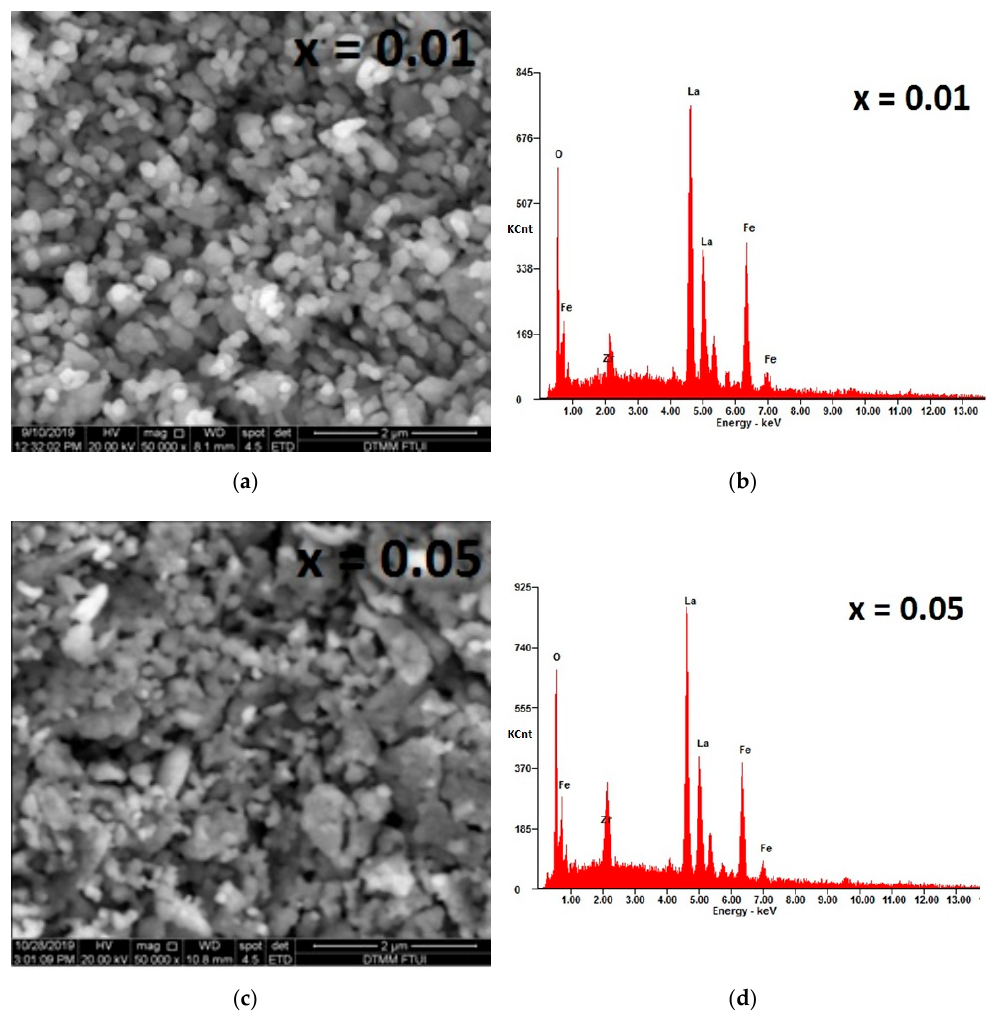
Figure 3. SEM-EDX of LaFe 1 − x Zr x O 3 annealed at 800 °C for 6 h. ( a ) and ( c ) represent SEM images of x = 0.01 and 0.05, respectively. ( b ) and ( d ) represent EDX spectrum of x = 0.01 and 0.05, respectively.